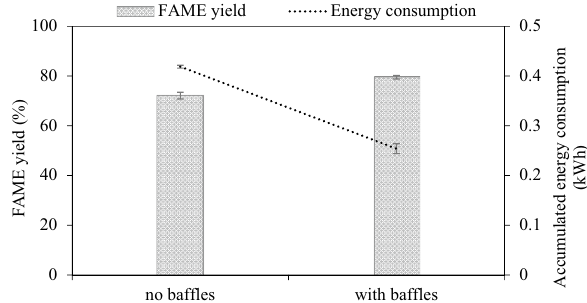
Figure 1. Effect of baffle plates on steady-state FAME yield (refined palm oil, 1000 mL, 25 mL/min, 1 wt% NaOH, 6:1 MeOH: oil molar ratio, 62–63